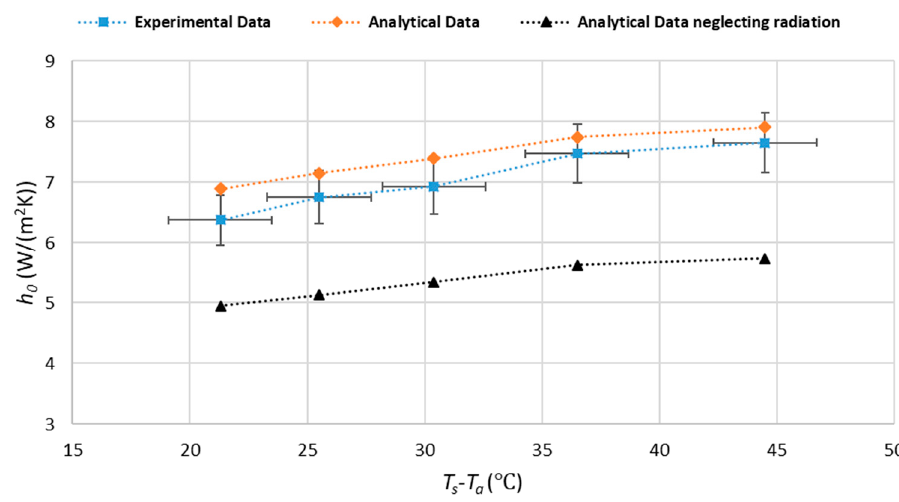
Figure 6. Analytical and experimental results of the heat-transfer coefficient versus temperature difference of TEFC housing and ambient.